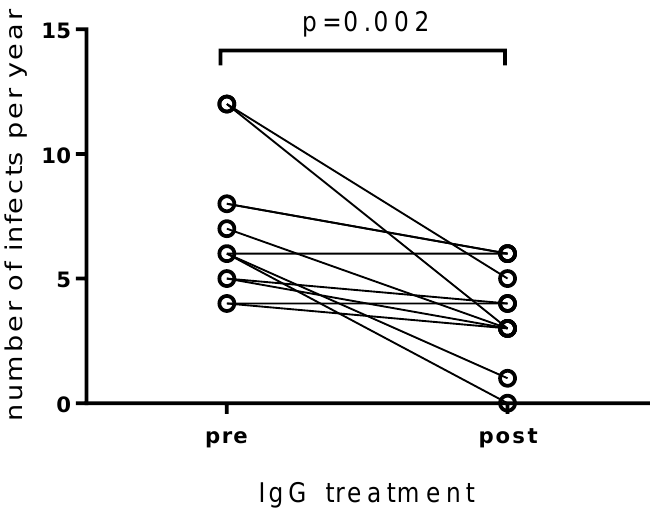
Figure 3. Numbers of infections per year in the 12 months before (pre) and 12 months after (post) initiation of IgG treatment are shown. Numbers of infections significantly decreased during the IgG treatment. A two-tailed Wilcoxon matched-pairs signed-rank test was performed for statistical analysis. We compared number of leukocytes, lymphocytes, erythrocytes, IgG and IgG subclass levels, CRP level, ANA and levels of several potential disease biomarkers (LDH, CK, soluble IL-2 receptor, IL-8, β 2 AdR and M3 AchR AAB and soluble CD26) pretreatment but observed no significant differences between responders and non-responders (Table S3). We observed, however, a trend of a higher pretreatment LDH level and lower soluble IL-2 receptor sCD25 in responders. When we included patients 4 and 8 with a response at months 6 and 9 in the responder group, responders had a significantly higher baseline serum LDH level compared to non-responders (Figure 4a). LDH levels did not decrease in the total patient cohort at month 3 during the dose escalation phase but from month 6 on (at month 9 p = 0.0137, Figure 4b). Further pretreatment values of the soluble IL-2 receptor were significantly lower in responder patients including patients 4 and 8 than in non-responders (Figure 4c). LDH and soluble IL-2 receptor did neither correlate with each other nor with disease severity or symptoms. IgG levels during treatment increased from median 8.5 g/L to maximum median 15.4 g/L at month 9 (Figure 4d). IgG and IgG subclass levels pretreatment did not correlate with response to treatment (Table S3). In the study by Lloyd et al. higher lymphocyte count pretreatment was associated with response to IgG treatment. Here, we could not confirm this observation (Table S3) [10]. When comparing patients not tolerating treatment to those receiving 12 months of treatment we observed no differences in clinical parameters. Interestingly, we observed a lower level of the biomarker sCD26 in the five patients who did not tolerate treatment or had early disease worsening compared to patients who completed IgG treatment (Figure